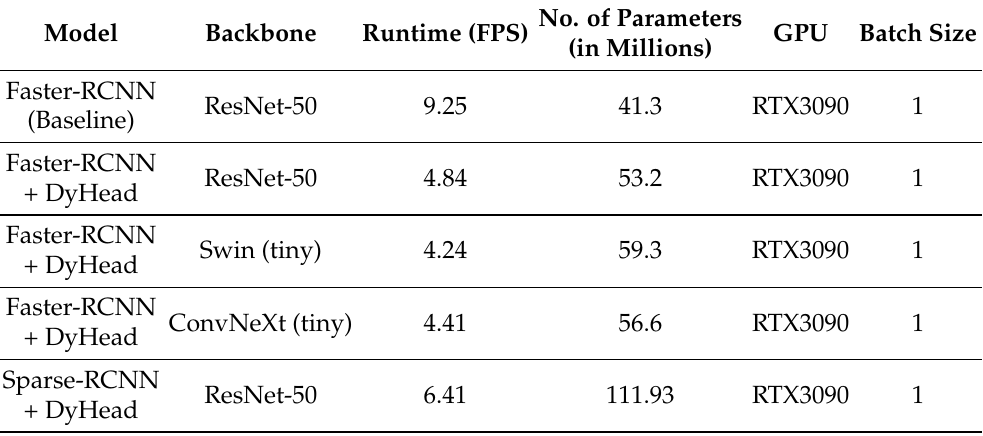
Table 9. The computational complexity of our algorithm with various configurations. The baseline configuration consists of a ResNet-50 backbone and Faster-RCNN as the head. All the rest use DyHead as the attention mechanism along with a backbone and the head. The addition of DyHead module adds an overhead to the runtime of the overall model, due to additional parameters. An interesting observation is the runtime of Sparse-RCNN with DyHead. Due to learned proposals, the model runs faster than its counterpart with a similar configuration, i.e., Faster-RCNN + ResNet-50 + DyHead. No. of Parameters Backbone Runtime (FPS) (in